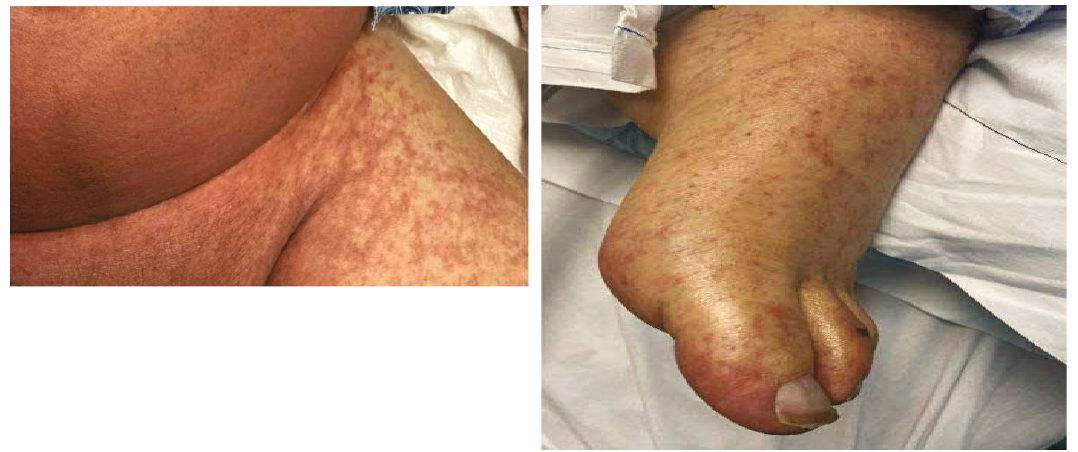
Figure 4: Maculopapular rash on trunk and